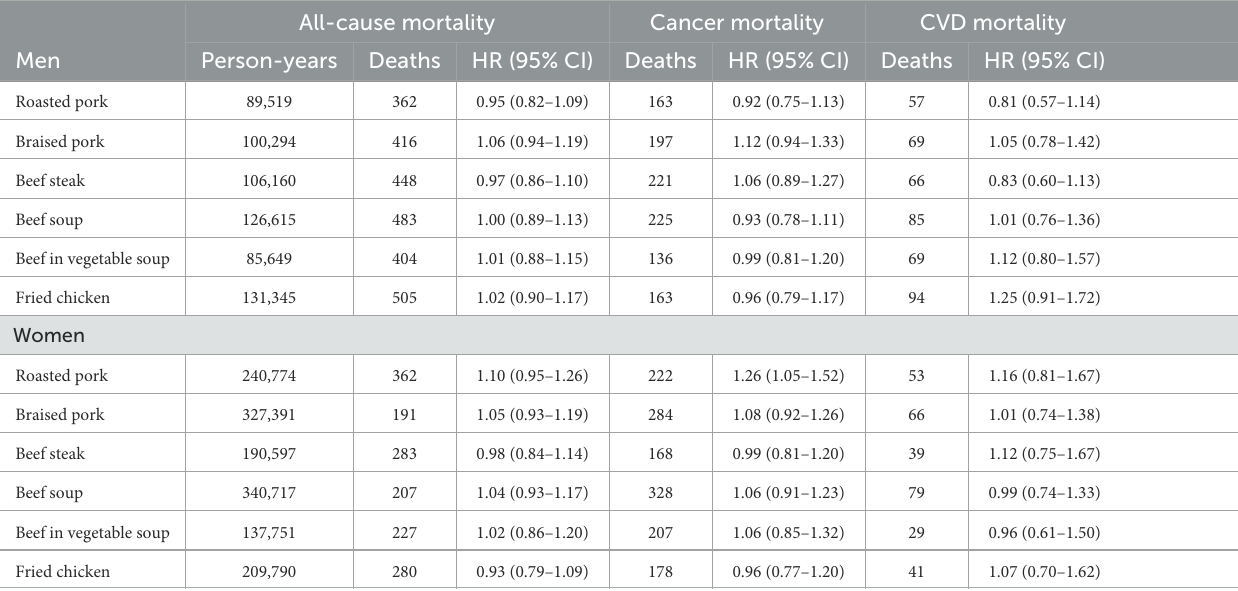
TABLE 2 Meat intake, all-cause mortality and cause-specific mortality according to meat preparation methods in the HEXA-G study in men. All-cause mortality Cancer